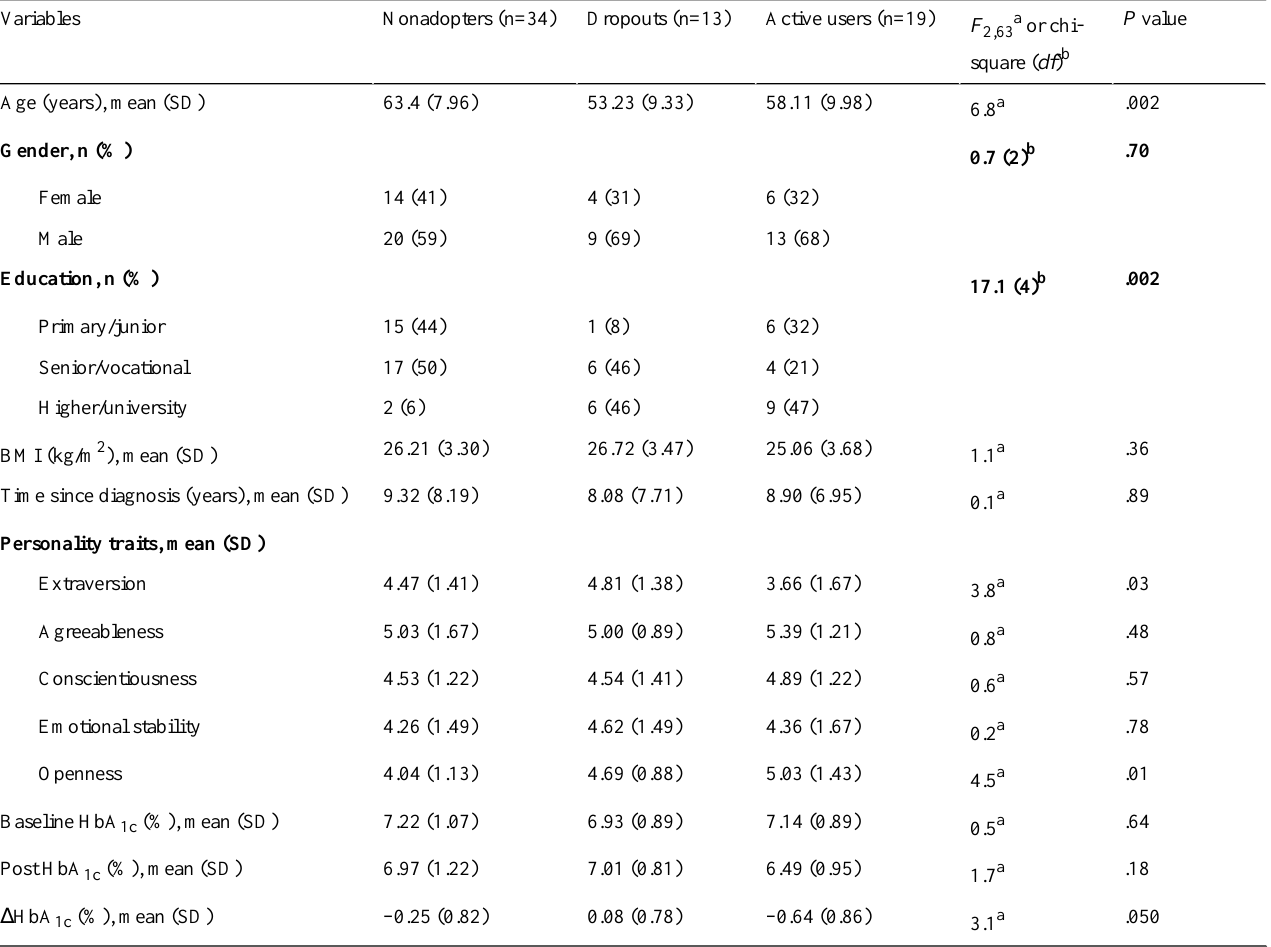
Table 4. Descriptive statistics after 3 months and the differences among categories